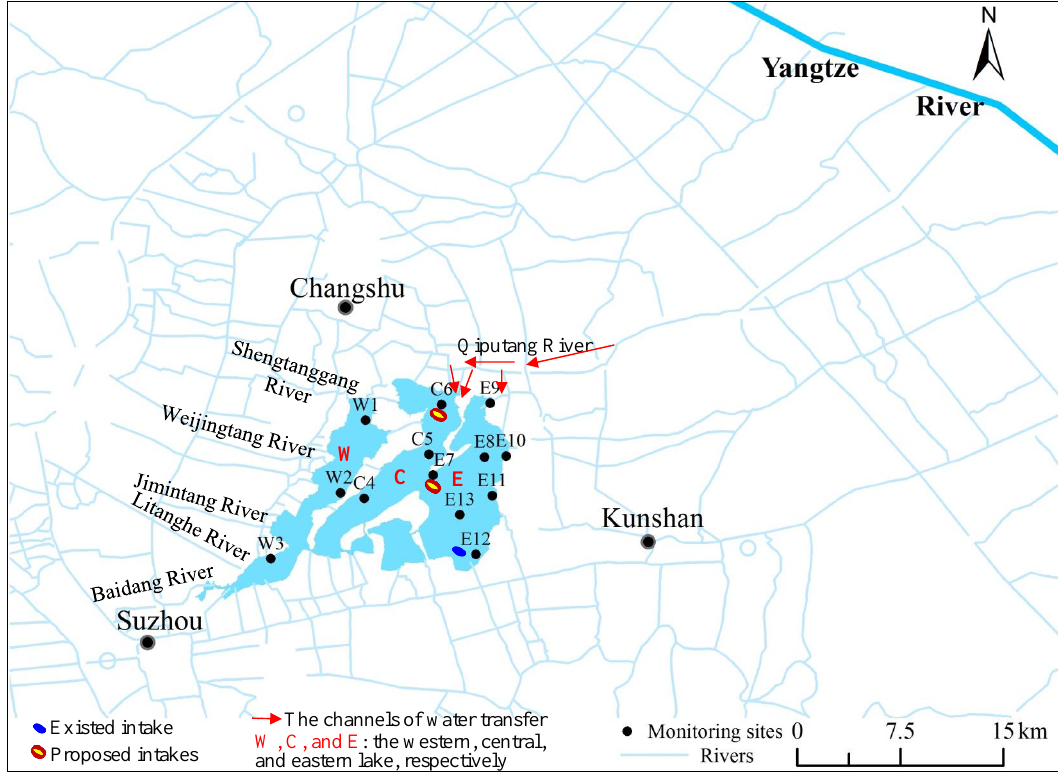
Figure 1. Location and measurement sites of Lake